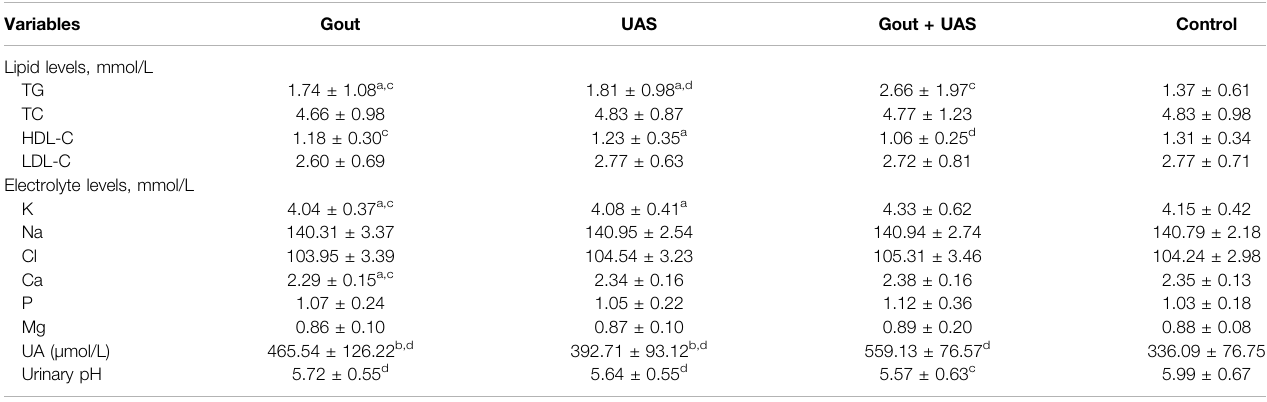
TABLE 2 | Biochemical parameters in different groups studied.